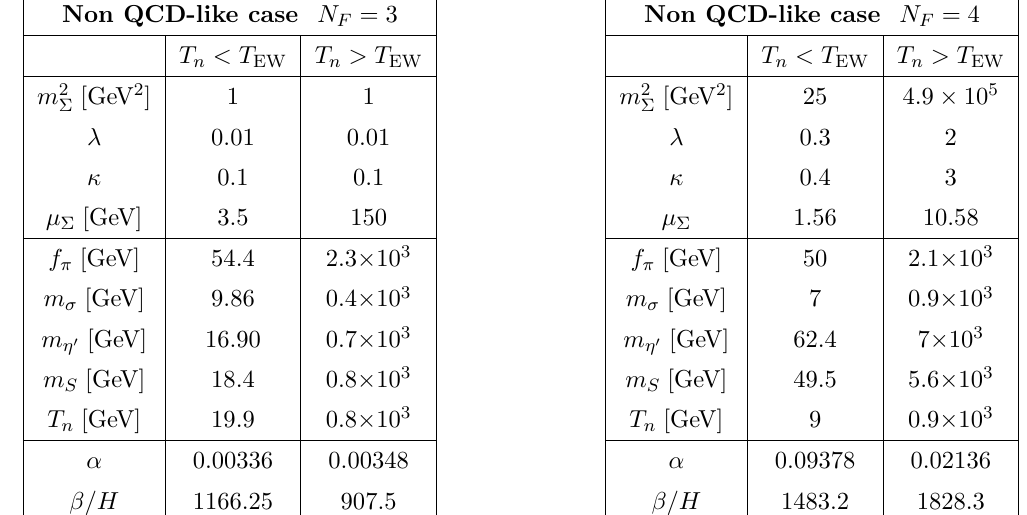
Table 2. Values of the linear sigma model parameters, physical meson masses and relevant quanti- ties entering the GW spectrum calculation of the N